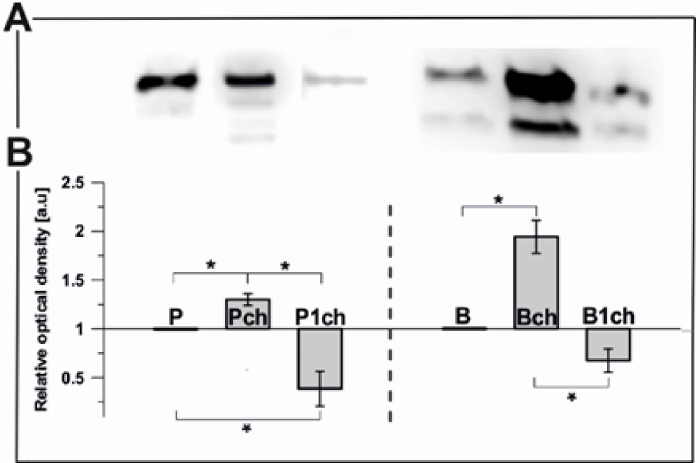
Figure 4. The relative optical density of the FBN1a protein (PGL35) in plastoglobule fractions ex- tracted from pea (P) and bean (B). The data presented in the graphs are based on the immunodetection of electrophoretically separated proteins ( A ) of isolated plastoglobules from plants grown under chilling stress conditions—after the first (1ch) and seventh (ch) day of low-temperature treatment in comparison to control plants ( B ). Presented data are mean values ± SD from 3 independent experiments; pairs of results marked with an asterisk differ significantly at p = 0.05 (one-way ANOVA with post-hoc Tukey